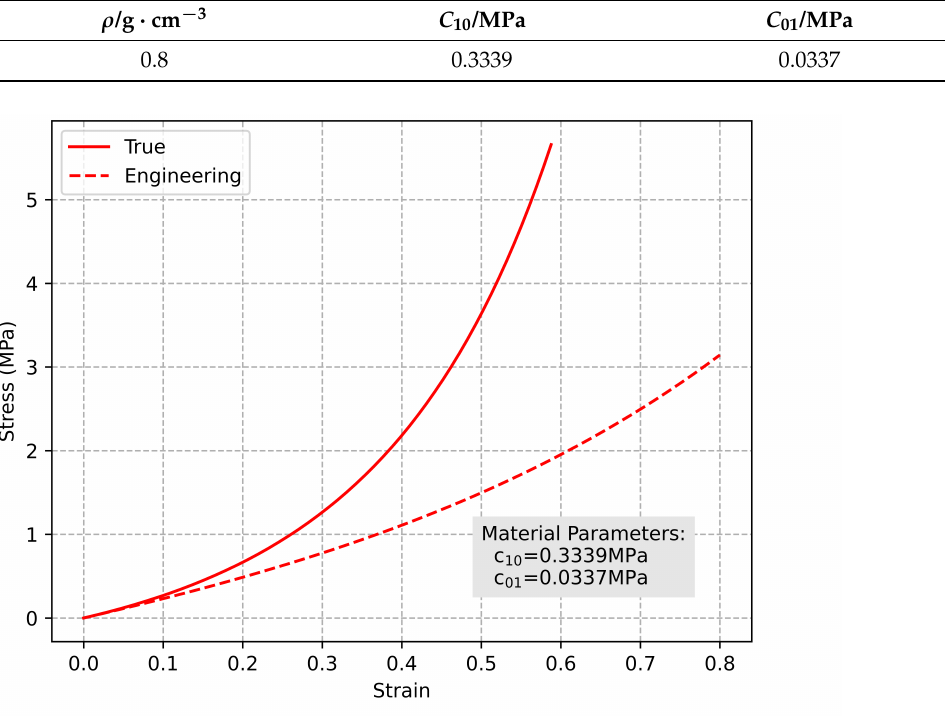
Figure 2. Stress–strain curve of the